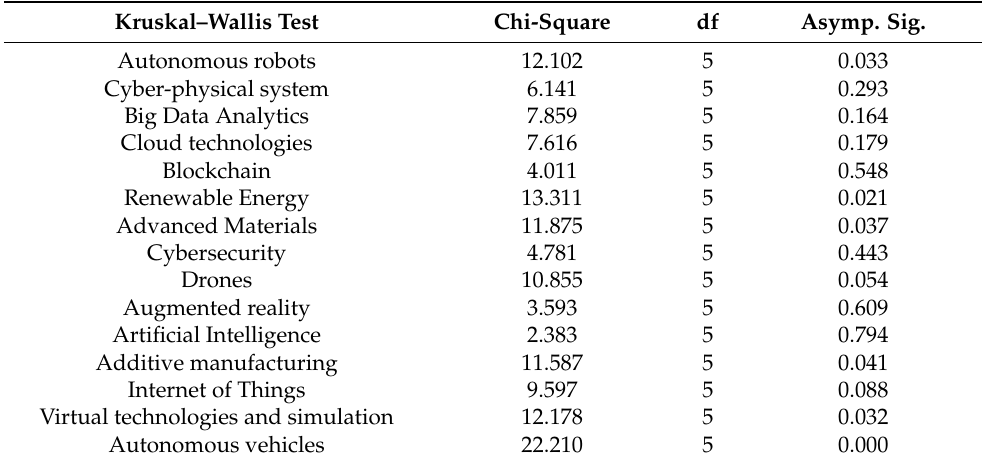
Table 11. Evaluation of null and alternative research hypotheses.